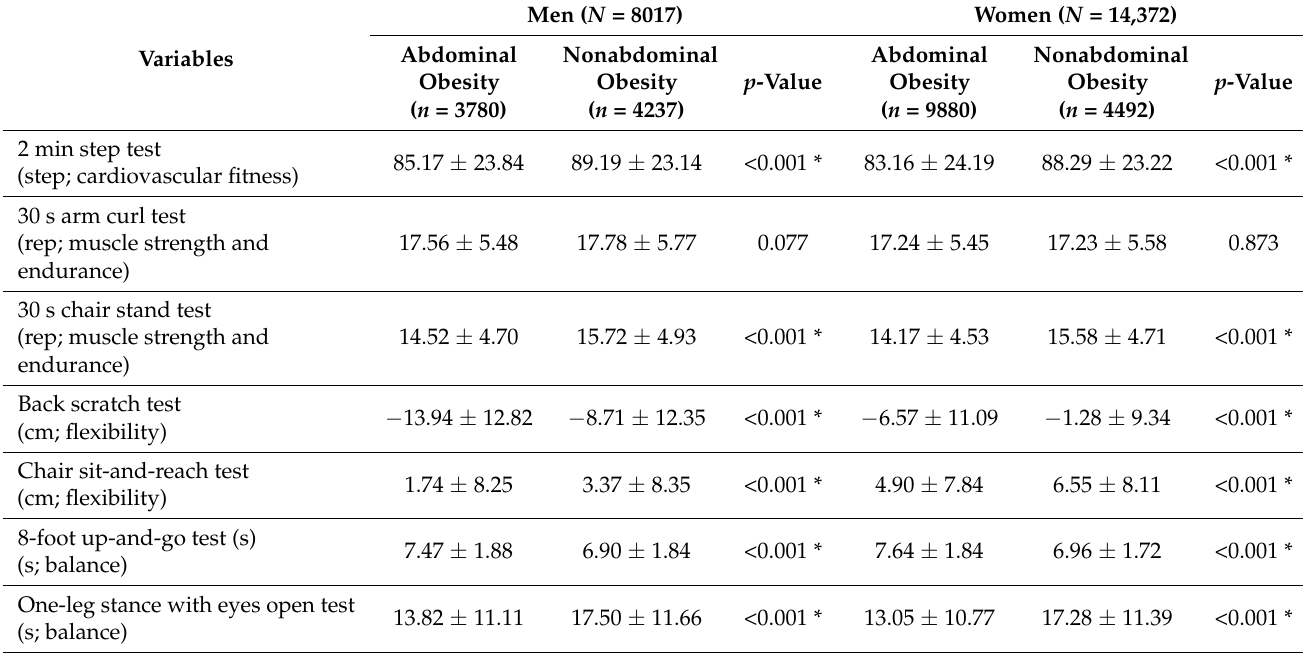
Table 2. Comparisons between abdominal obesity status and functional fitness performance.